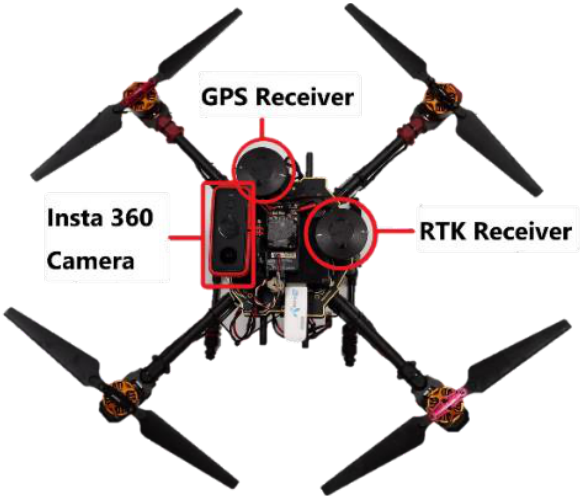
Figure 5. Tarot Ironman 650 with GPS Receiver, RTK Receiver and Insta 360 Camera Facing Upwards.